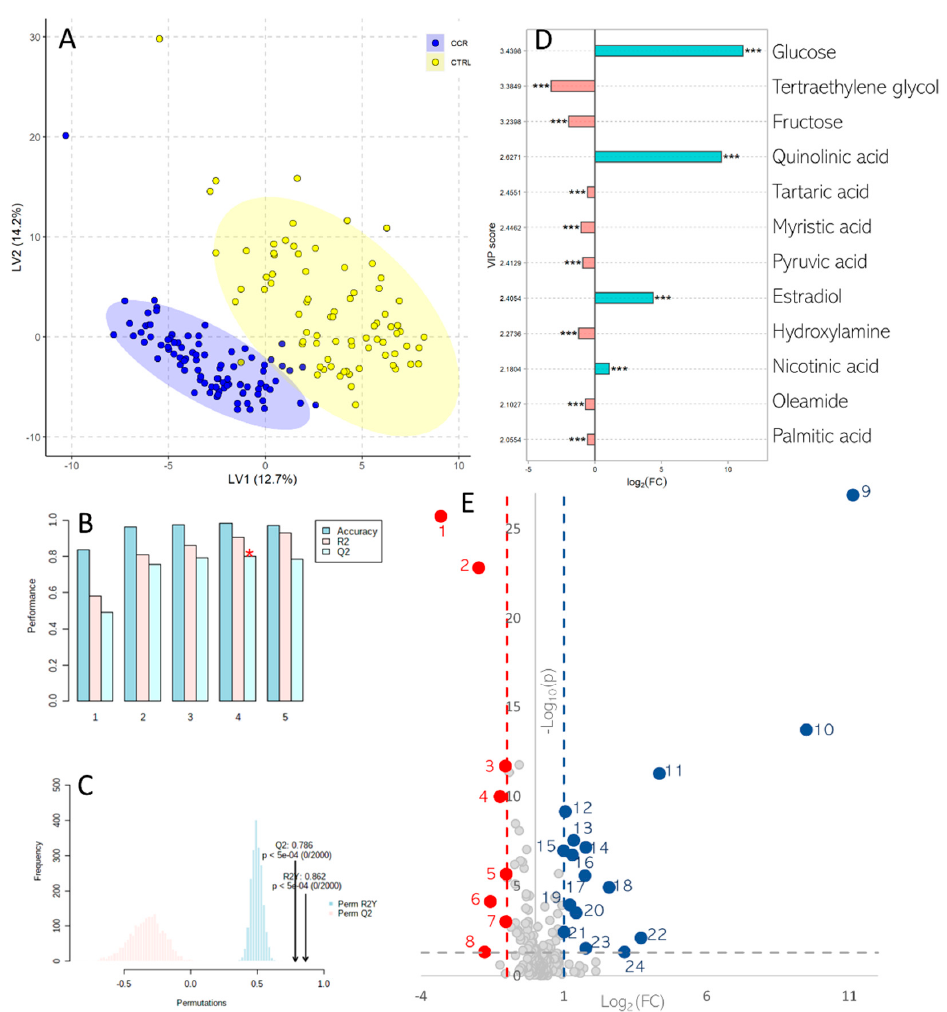
Figure 2. Partial least square discriminant analysis (PLS-DA) score plot performed to classify CTRL and CRC subjects (panel A ). For each axis, the percentage of explained variance is reported in parentheses. Panel ( B ) reports the PLS-DA classification performance using increasing number of latent variables. The red star indicates the best classifier. ( C ) Permutation test results in which models were built by randomly assigning the class label and then comparing the performance of the permuted models with that of the original model built with the correct class assignment. These were statistically different (based on 2000 permutations), highlighting the lack of overfitting in the original model. ( D ) The metabolites showing a variable importance in projection (VIP) score higher than 2.0. The blue bars represent metabolites increased in CTRL, while the red bars represent the metabolites decreased in CTRL with respect to CRC. *** represent metabolites with a p -value < 0.001 ( E ) Volcano plot reporting metabolite concentration fold-changes and their statistical significance when comparing CTRL vs. CRC subjects. 1. Galactose, 2. 4-Hydroxybenzyl alcohol, 3. Myristic